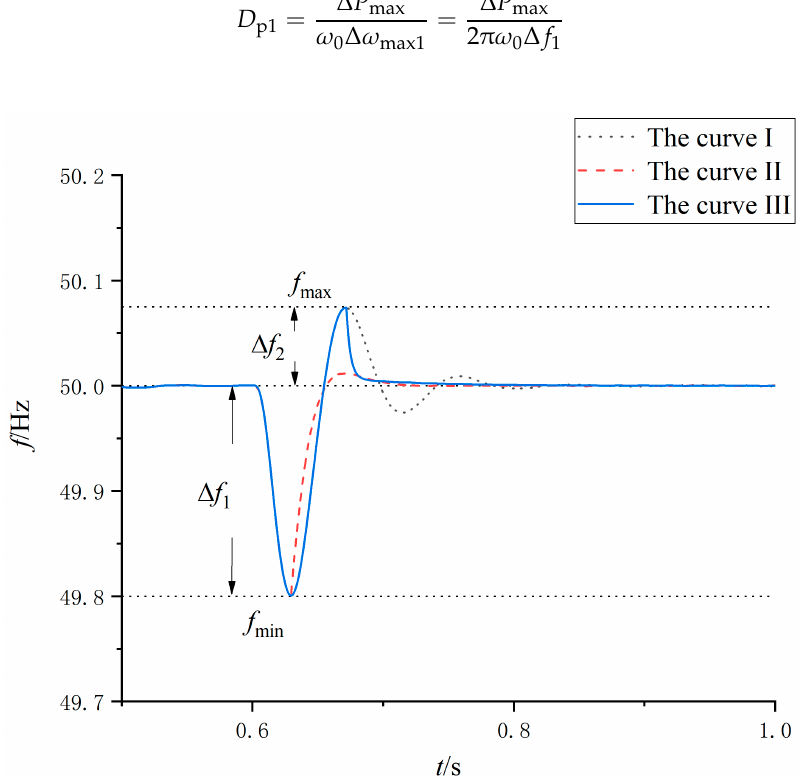
Figure 3. Frequency change trend of active load shedding.